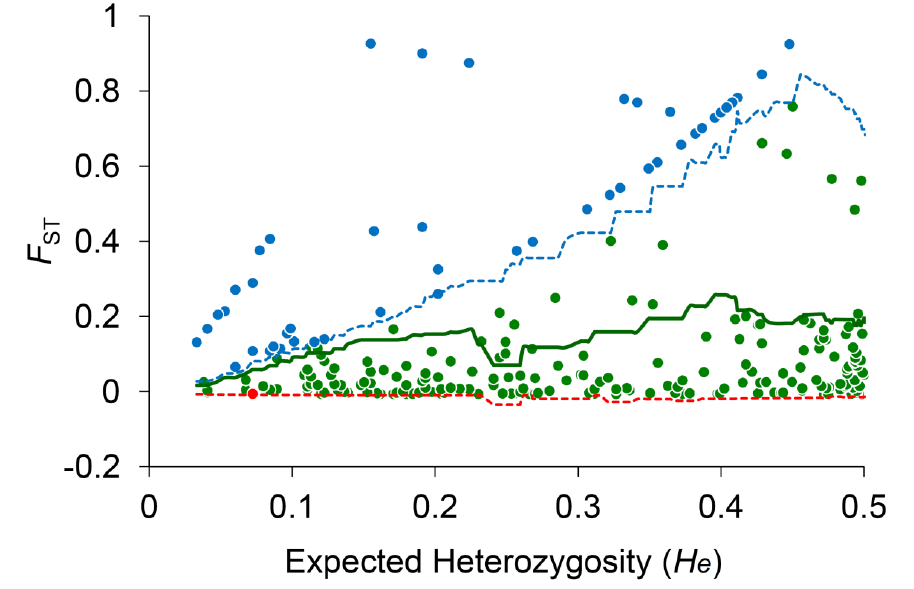
Figure A1. Examination of neutrality of AFLP loci based on Beaumont and Nichols’s [56] method by program Mcheza [46]. Loci located within the 95% confidence intervals are taken as neutral loci (solid dots) and the positive (open diamonds) and negative outliers (open squares) are taken as candidate loci under positive and balancing selection,